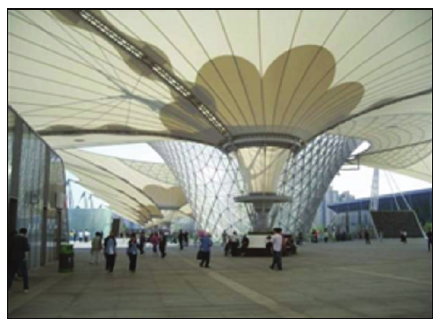
Figure 1: Membrane roof of Shanghai EXPO Axis.